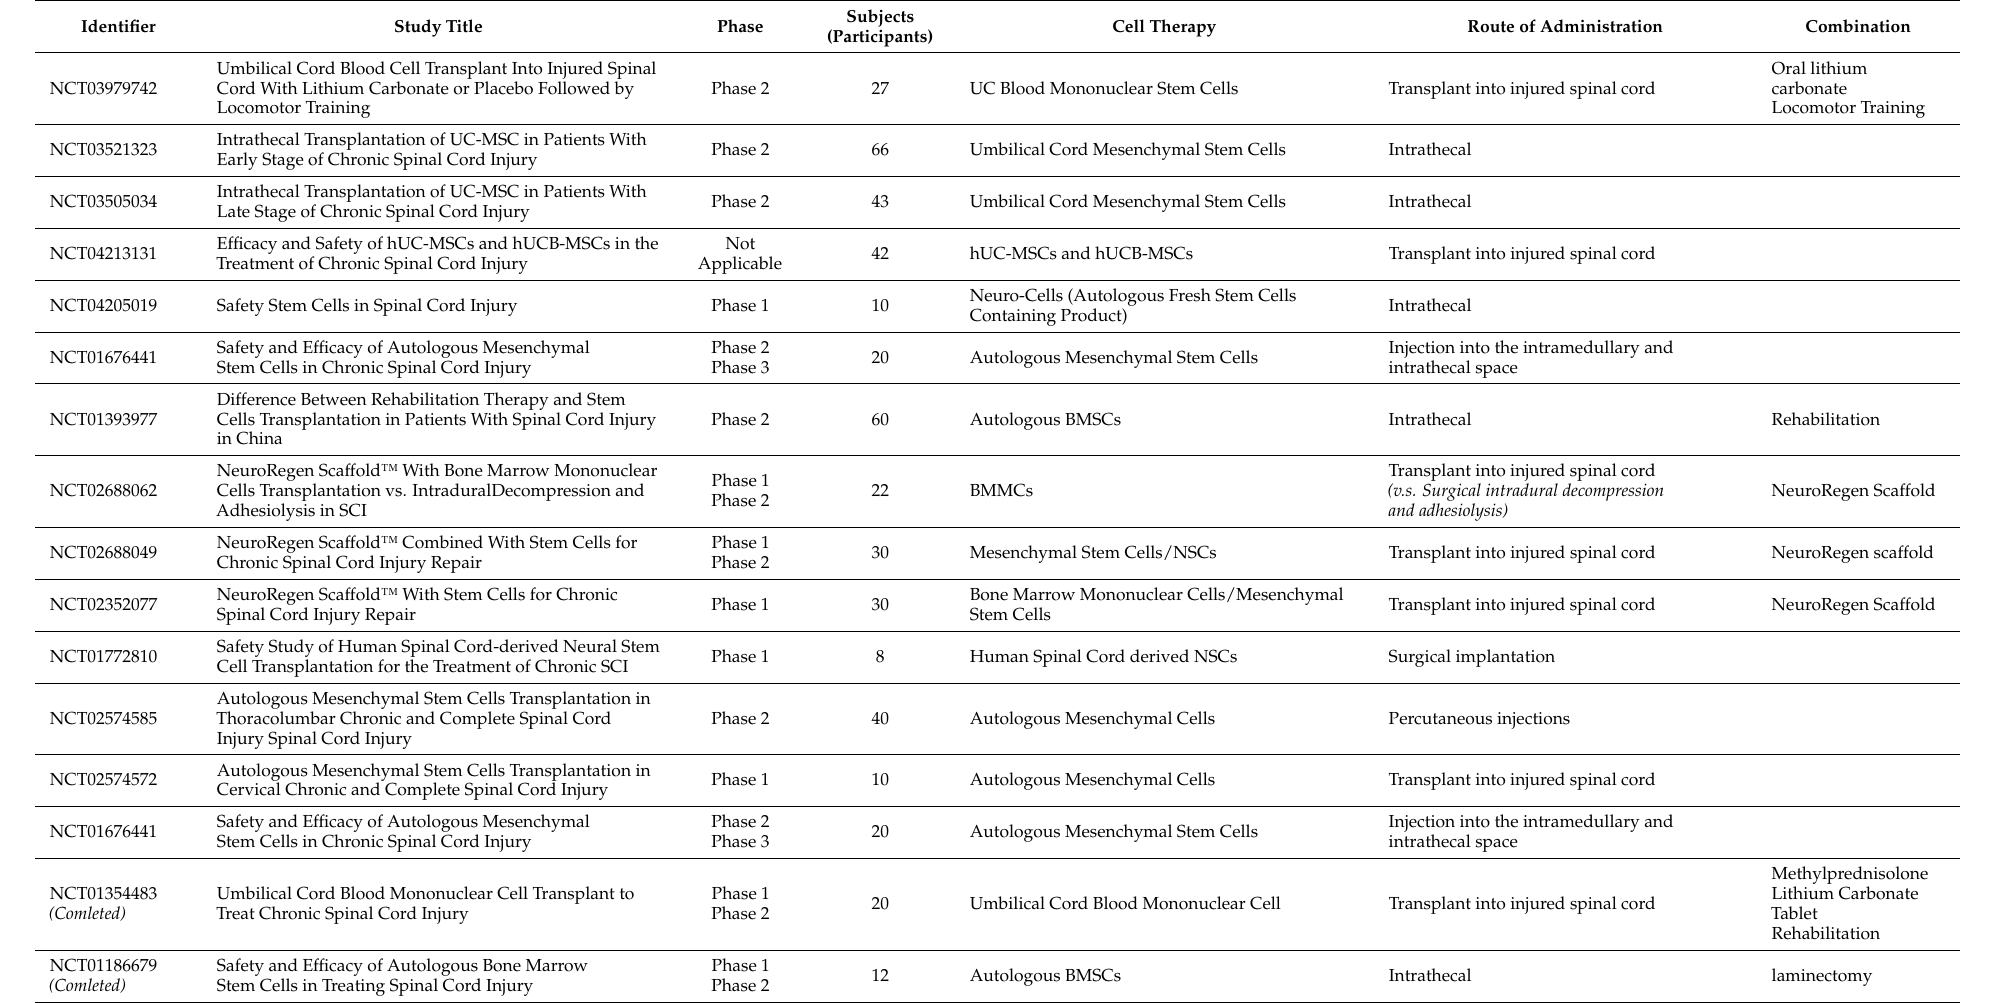
Table 1. The ongoing clinical trials currently targeting chronic SCI and important completed clinical trials [ClinicalTrials.gov. Available online: https://www.clinicaltrials.gov/ (accessed on 1 June